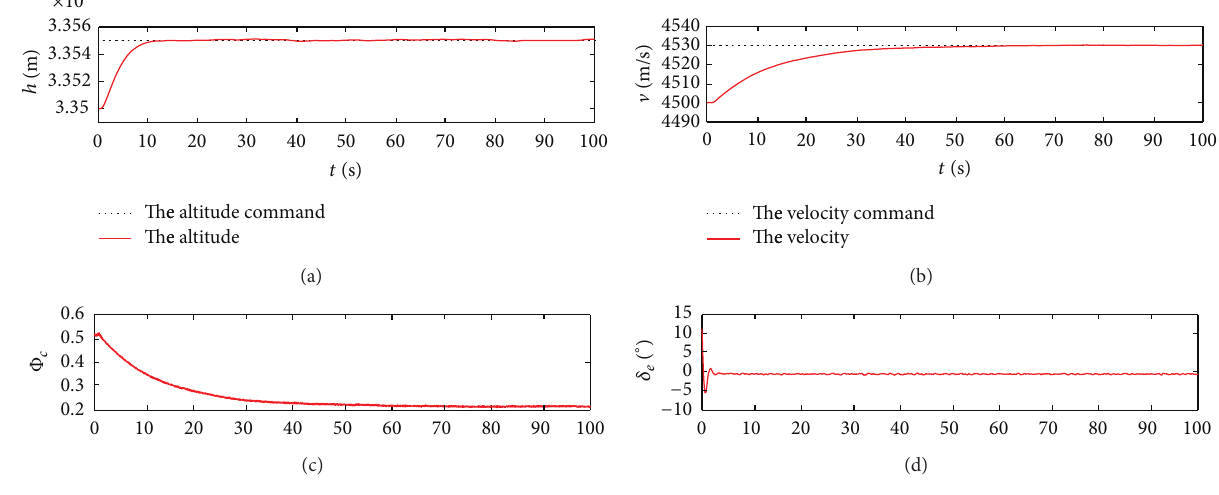
Figure 9: Change curves of the control inputs and angle of